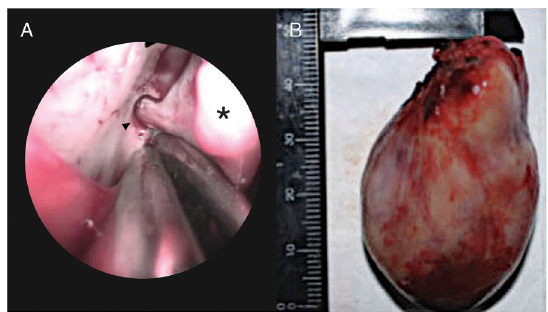
presentation.Figure 2. A . Intraoperative endoscopic view of the sphenopalatine artery (black arrowhead) supplying the mass (black asterisk) and B . Gross specimen measuring 4.7 × 3.2 × 2.7 cm. Adobe Photoshop CC 20.01 release was used to erase identifying patient details and sharpen the image (applied to entire image 2 B